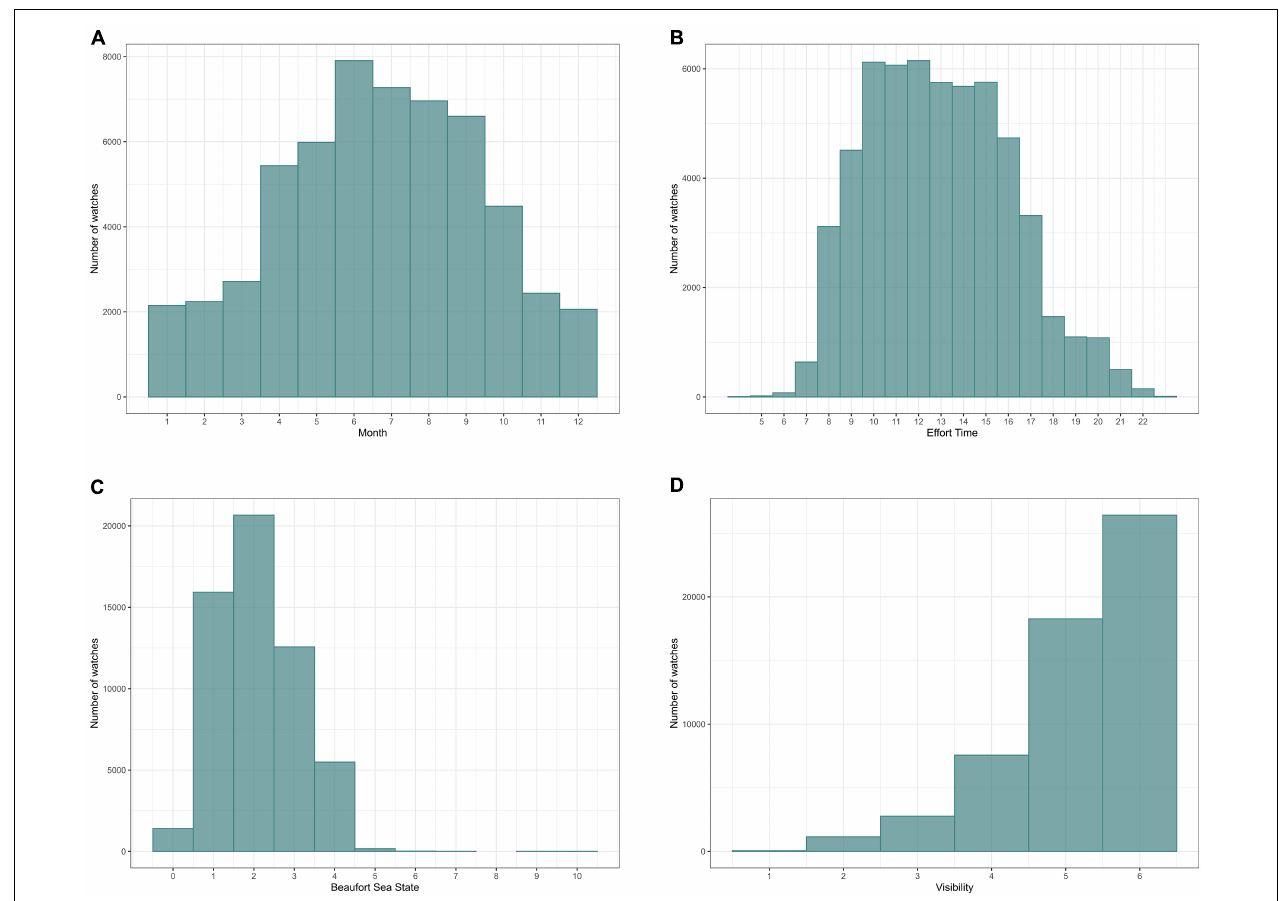
FIGURE 2 | Effort distribution in relation to (A) month; (B) time of day; (C) (Beaufort) sea state and (D) visibility. The y -axis indicates the total number of watches.